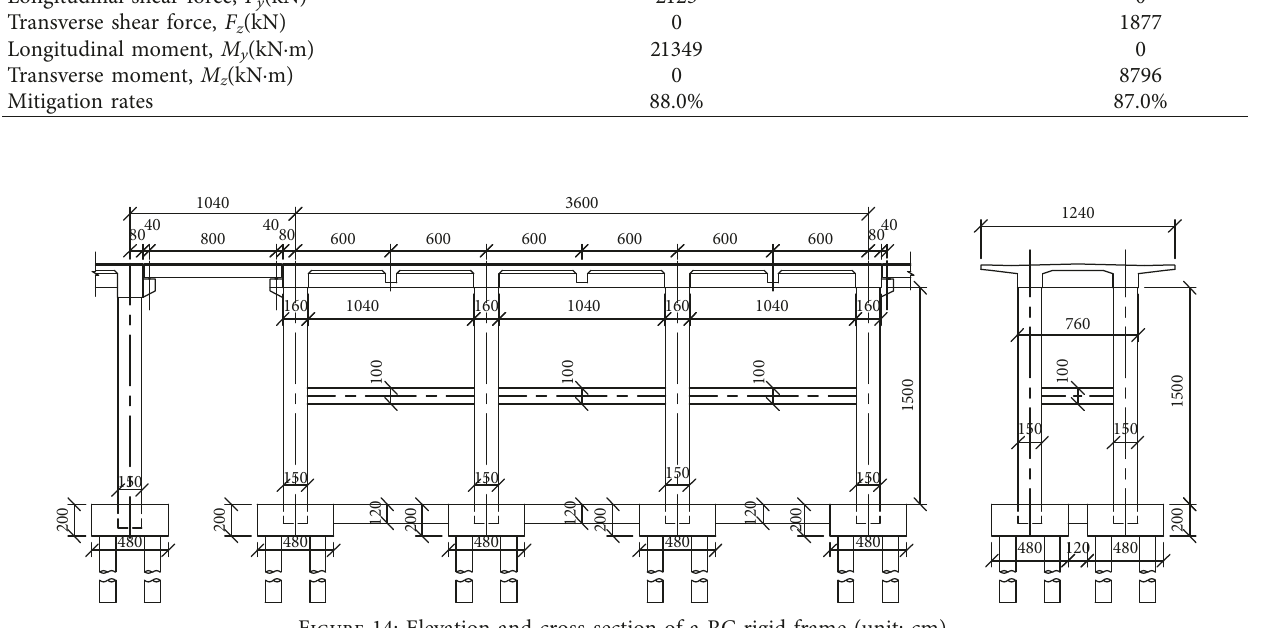
Figure 14: Elevation and cross-section of a RC rigid frame (unit: cm).